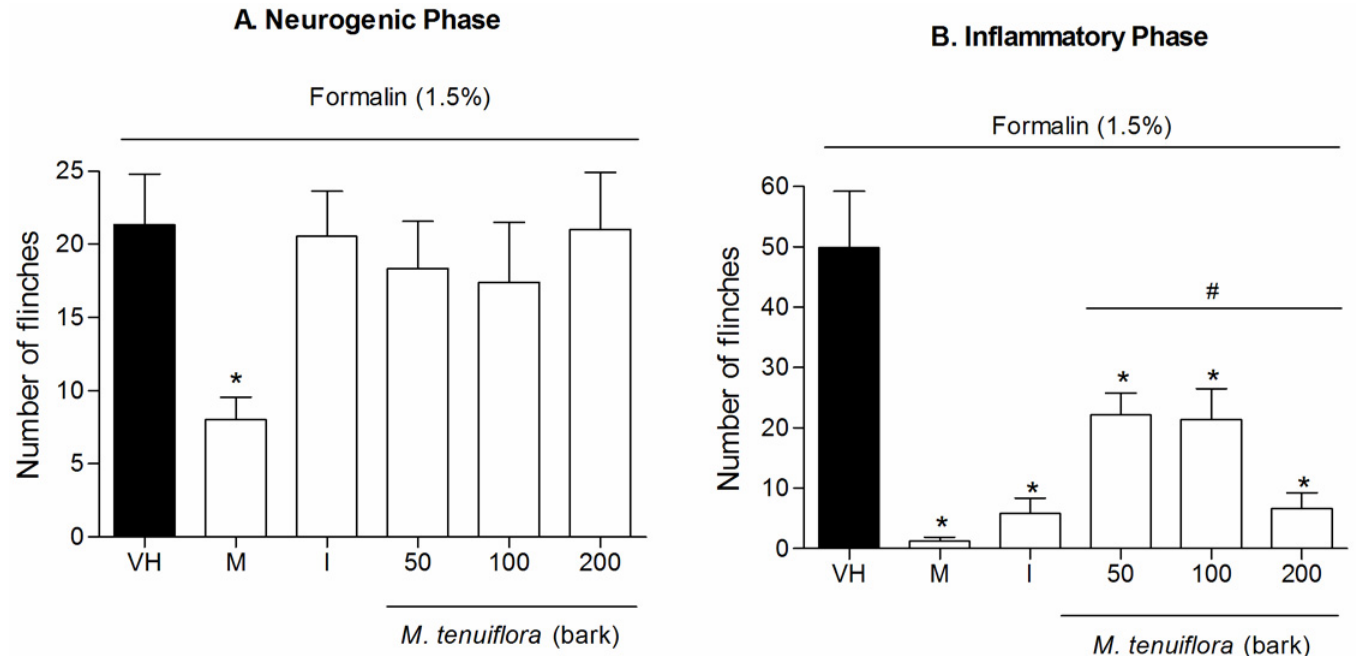
Fig 3. Effects of ethanolic extract of M . tenuiflora bark on the response to nociception induced by intraplantar formalin injection in mice during the neurogenic phase (3A) and inflammatory phase (3B). Morphine (M, 5 mg/kg, s.c.) and indomethacin (I, 10 mg/kg, i.p.) were the positive control group. VH is the vehicle group (negative control). The ethanolic extract of M . tenuiflora bark was tested at doses of 50, 100 or 200 mg/kg (s.c.). The results are presented as the mean ± S.D. (n = 8) of the number of flinches in the injected paw for a period of 30 min. Statistical significance was calculated by ANOVA followed by Bonferroni's test. * P < 0.05 compared to the vehicle-negative control treated group. # P > 0.05 compared to the indomethacin or morphine — positive control